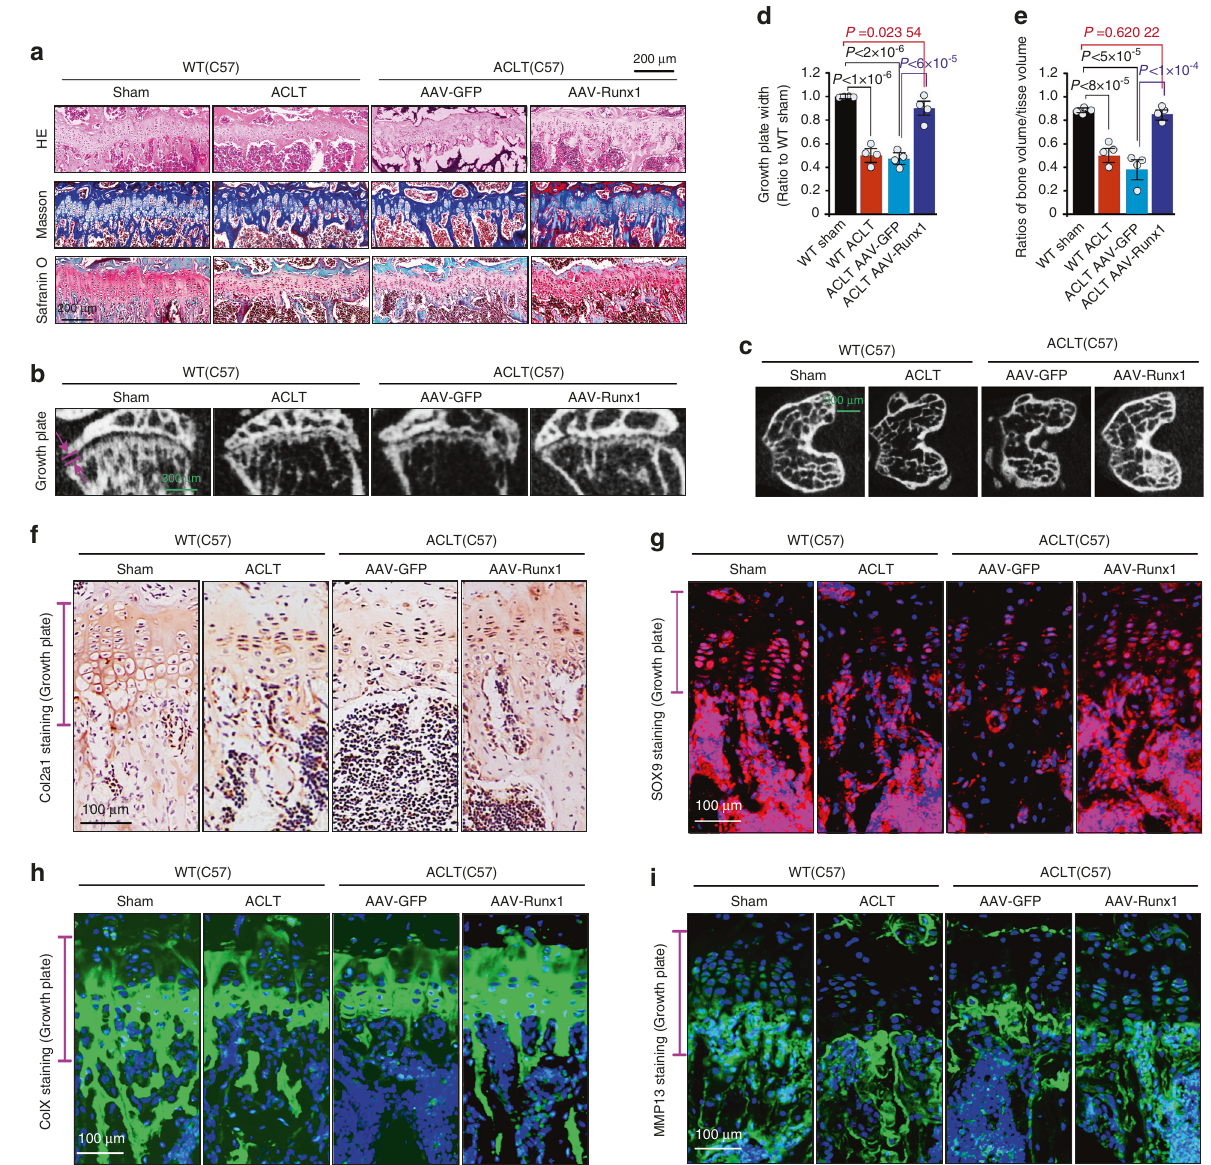
Fig. 4 AAV-Runx1 overexpression alleviates the pathological changes in growth plate cartilage. a Histological staining, including H&E, Masson, and safranin O, showing the effects of AAV-Runx1 overexpression on growth plate cartilage at 24 weeks after ACLT surgery. b μ -CT results showing changes in the thickness of growth plate cartilage in AAV-Runx1-overexpressing articular cartilage at 24 weeks after ACLT surgery. c μ -CT results showing the changes in subchondral cancellous bone in AAV-Runx1-overexpressing articular cartilage at 24 weeks after ACLT surgery. d Quantitative analysis of the thickness (width) in b in growth plate cartilage in AAV-Runx1-overexpressing mice. e Quantitative analysis of BV/TV in c in AAV-Runx1-overexpressing mice at 24 weeks after ACLT surgery. f IHC staining showing the changes in Col2a1 in the growth plate in AAV-Runx1-overexpressing articular cartilage at 24 weeks after ACLT surgery. g Immuno fl uorescence staining showing the changes in SOX9 in the growth plate in AAV-Runx1-overexpressing articular cartilage at 24 weeks after ACLT surgery. h Immuno fl uorescence staining showing the changes in ColX in the growth plate in AAV-Runx1-overexpressing articular cartilage at 24 weeks after ACLT surgery. i Immuno fl uorescence staining showing the changes in MMP13 in the growth plate in AAV-Runx1-overexpressing articular cartilage at 24 weeks after ACLT surgery. These results are based on at least three independent experiments ( n = 3). All signi fi cance data presented in d and e are based on two-tailed Student ’ s t